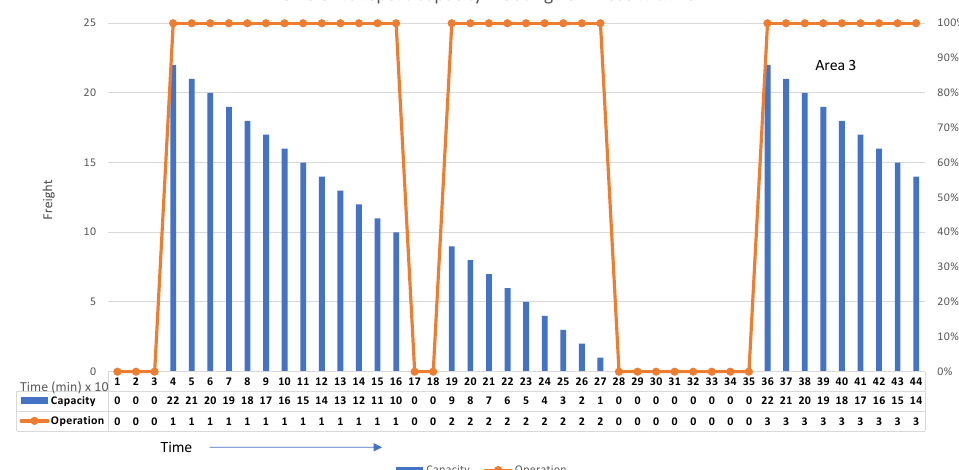
Figure 4. Vehicle transport capacity over the delivery time.